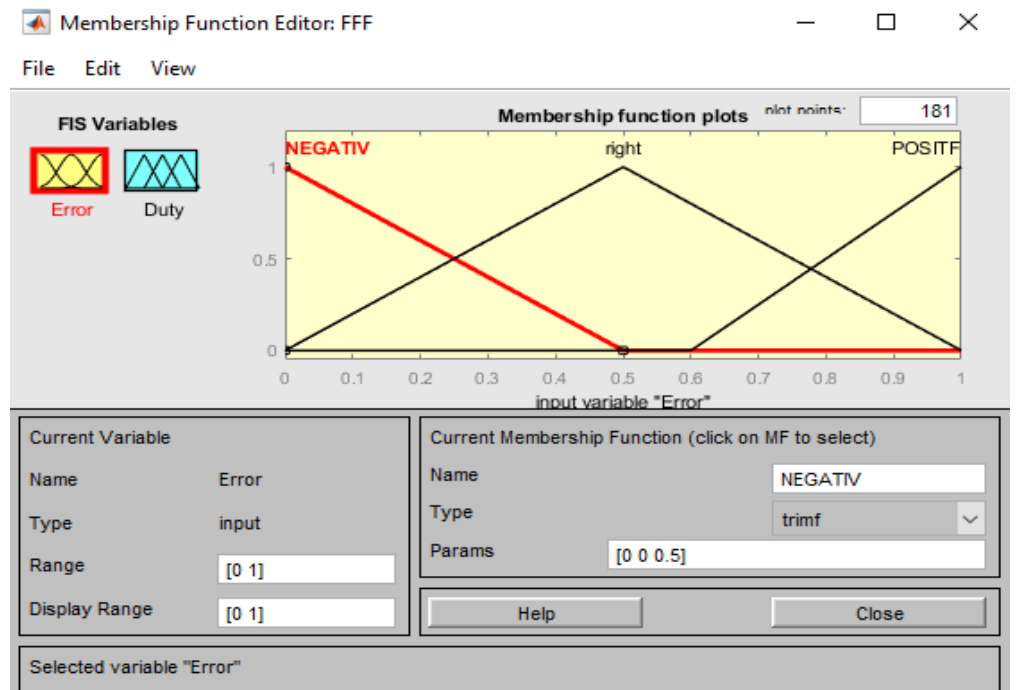
Figure 12. Error signal membership